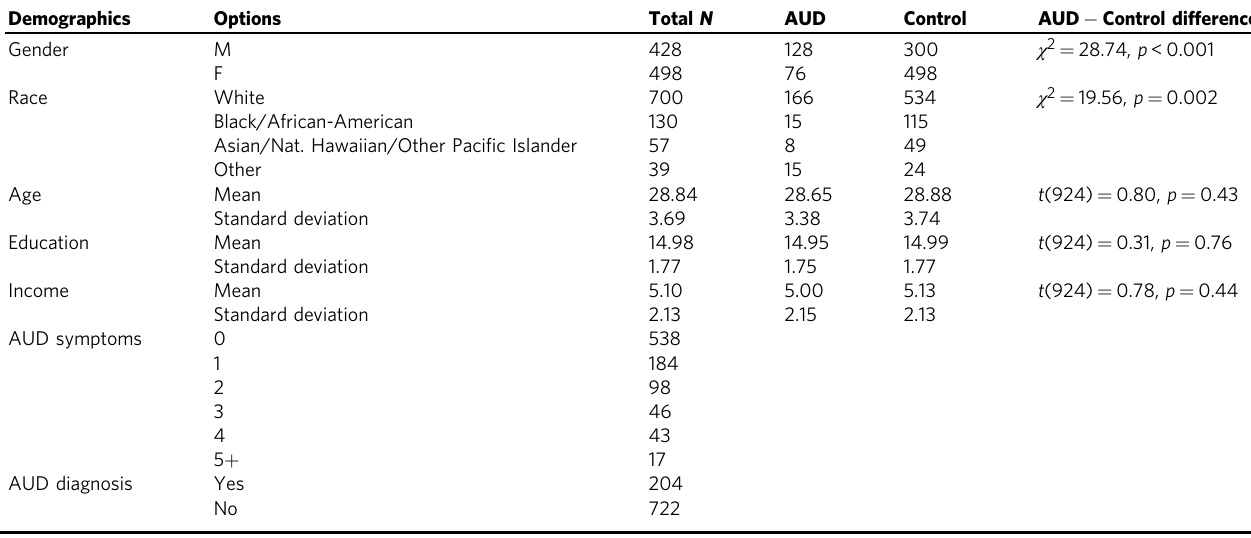
Table 2 Demographic characteristics of the fi nal sample ( n = 926).